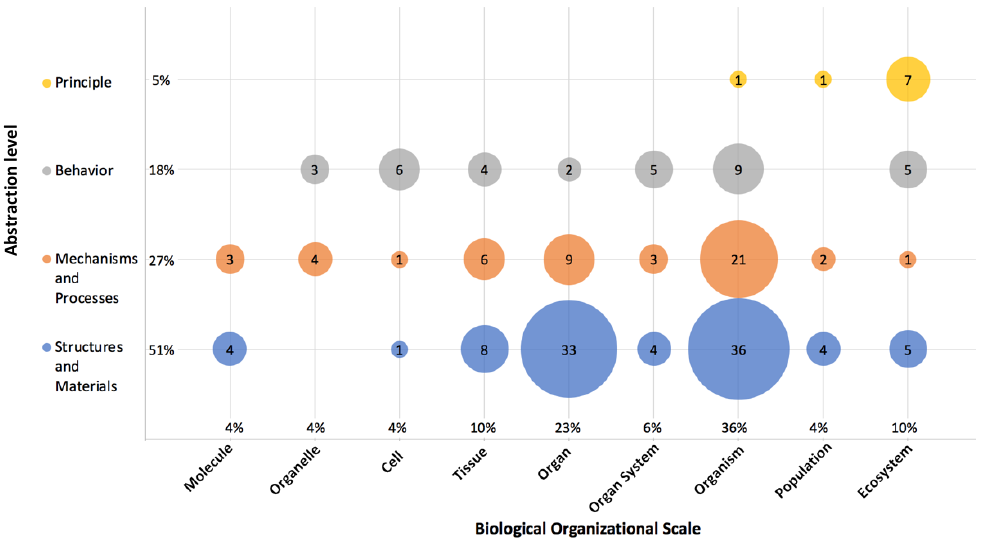
Figure 4. Level-Nature Distribution of Biomimetic Designs ( n = 188).